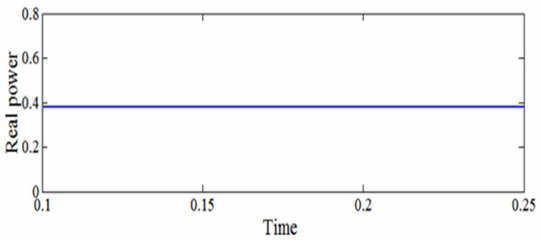
Figure 38. Real power demand from the load